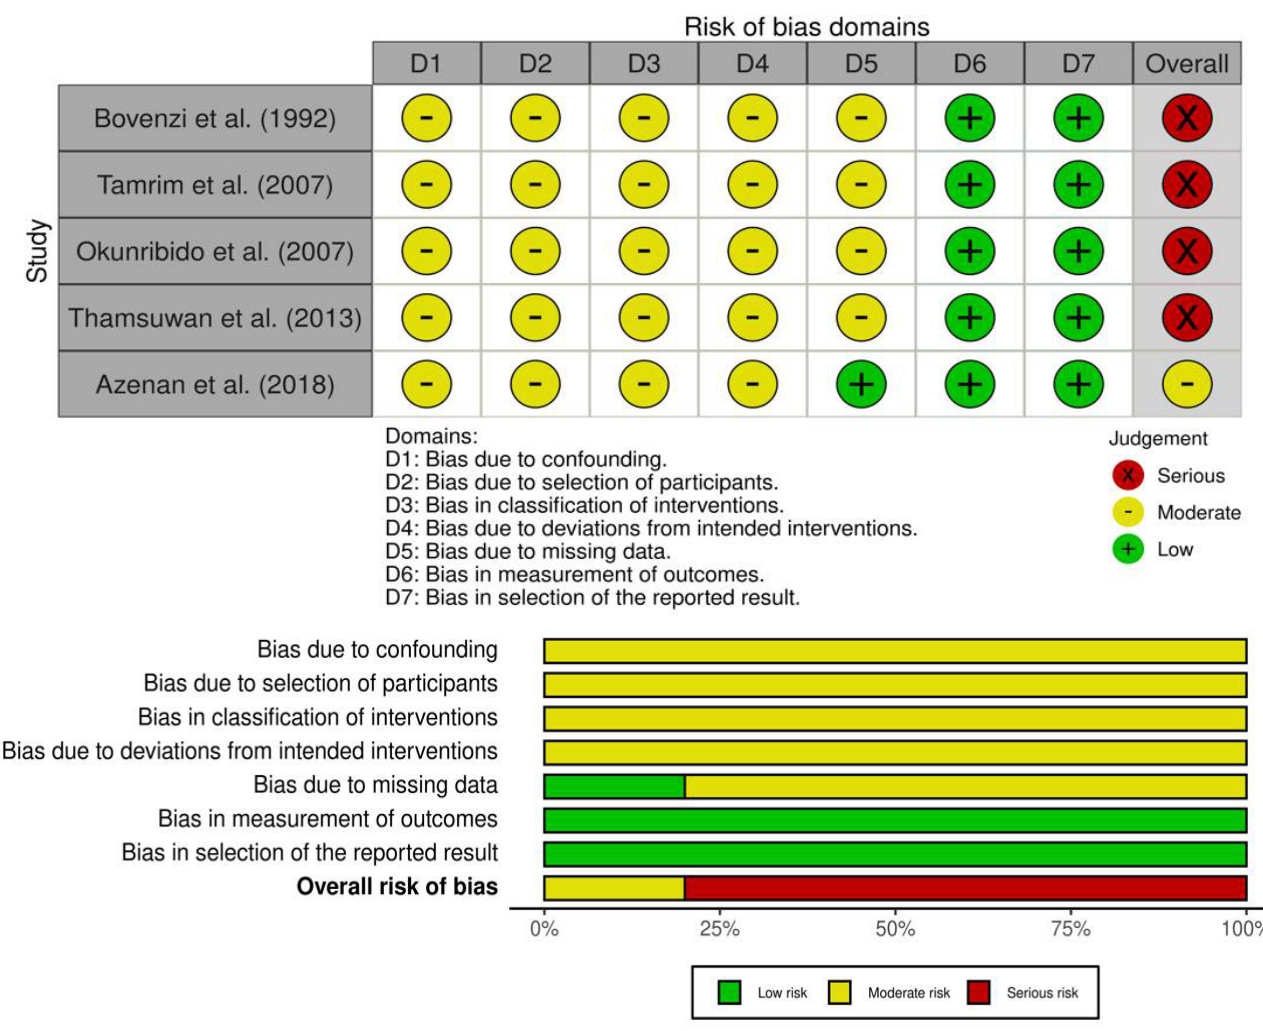
Figure 2. ACROBAT-NRSI risk of bias.